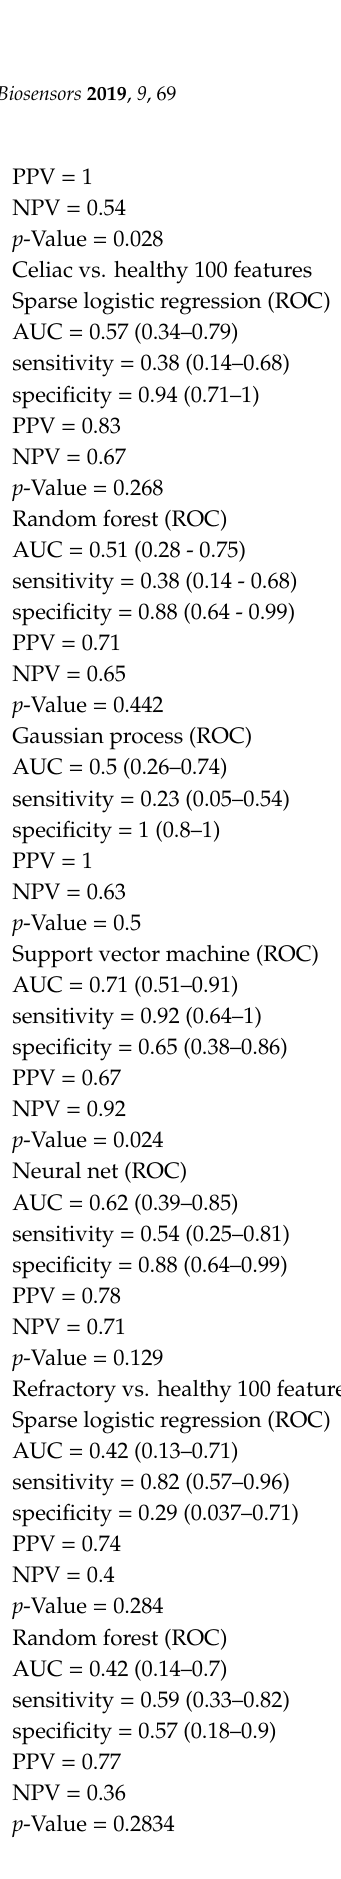
PPV = 1 NPV = 0.54 p -Value = 0.028 Celiac vs. healthy 100 features Sparse logistic regression (ROC) AUC = 0.57 (0.34–0.79) sensitivity = 0.38 (0.14–0.68) specificity = 0.94 (0.71–1) PPV = 0.83 NPV = 0.67 p -Value = 0.268 Random forest (ROC) AUC = 0.51 (0.28 - 0.75) sensitivity = 0.38 (0.14 - 0.68) specificity = 0.88 (0.64 - 0.99) PPV = 0.71 NPV = 0.65 p -Value = 0.442 Gaussian process (ROC) AUC = 0.5 (0.26–0.74) sensitivity = 0.23 (0.05–0.54) specificity = 1 (0.8–1) PPV = 1 NPV = 0.63 p -Value = 0.5 Support vector machine (ROC) AUC = 0.71 (0.51–0.91) sensitivity = 0.92 (0.64–1) specificity = 0.65 (0.38–0.86) PPV = 0.67 NPV = 0.92 p -Value = 0.024 Neural net (ROC) AUC = 0.62 (0.39–0.85) sensitivity = 0.54 (0.25–0.81) specificity = 0.88 (0.64–0.99) PPV = 0.78 NPV = 0.71 p -Value = 0.129 Refractory vs. healthy 100 features Sparse logistic regression (ROC) AUC = 0.42 (0.13–0.71) sensitivity = 0.82 (0.57–0.96) specificity = 0.29 (0.037–0.71) PPV = 0.74 NPV = 0.4 p -Value = 0.284 Random forest (ROC) AUC = 0.42 (0.14–0.7) sensitivity = 0.59 (0.33–0.82) specificity = 0.57 (0.18–0.9) PPV = 0.77 NPV = 0.36 p -Value =